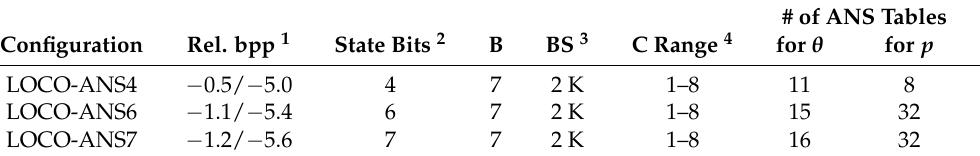
Table 2. Codec configurations used in the